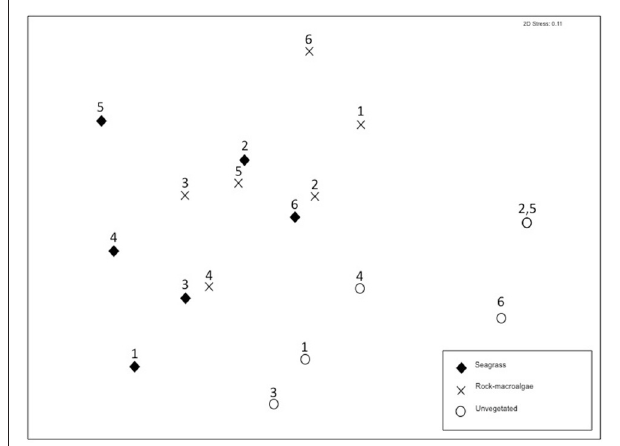
FIGURE 3 | Non-metric multidimensional scaling (nMDS) based on Bray-Curtis similarity coordinates for presence/absence of fish species separated into the three studied shallow-water habitats. Site numbers are labeled (compare with Figure 1 ); note that two unvegetated habitat sites overlap.